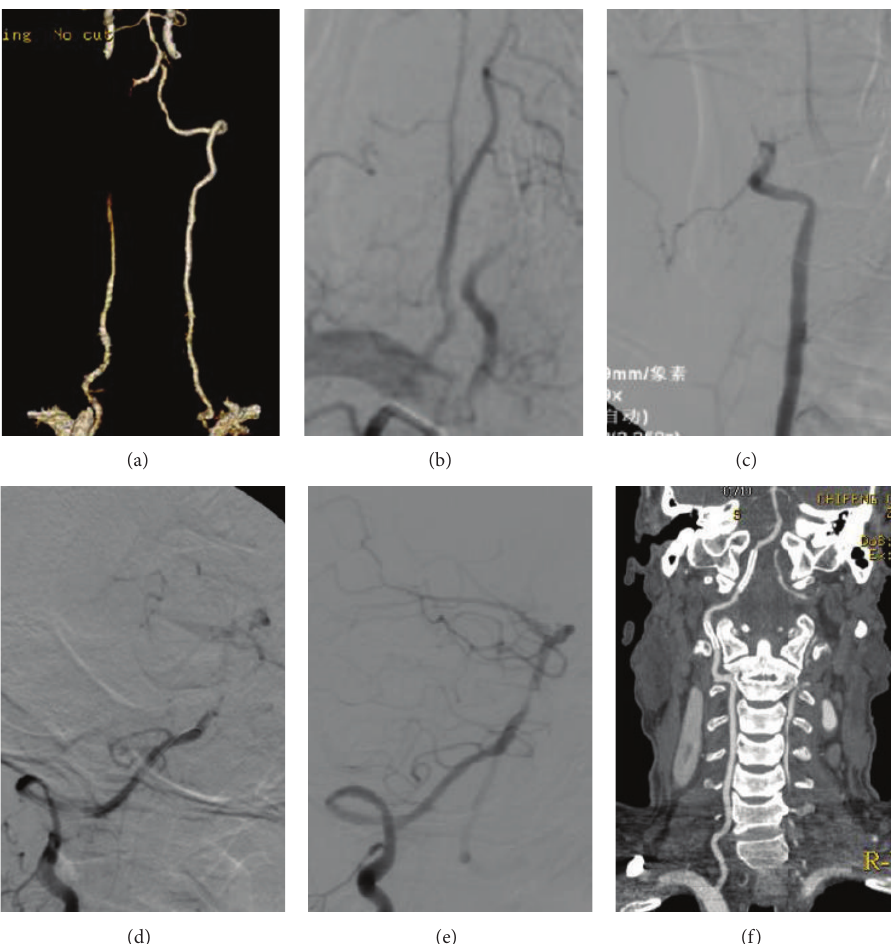
Figure 1: A 62-year-old man (case 3) with right intracranial vertebral artery (ICVA) total occlusion and tandem occlusion of the V3 by CTA (a) and DSA ((b), (c)). Contralateral severe stenosis of the V4 and tortuosity of the V1 were confirmed by CTA (a). The lesion was predilated with a 2 × 20 mm Invatec balloon and covered with a 3 × 18 mm Apollo stent for the V4 and a 3 × 15 mm Apollo stent for the V3 ((d), (e)). A 24-month CTA follow-up showed patency of the right V3 and V4 without in-stent stenosis